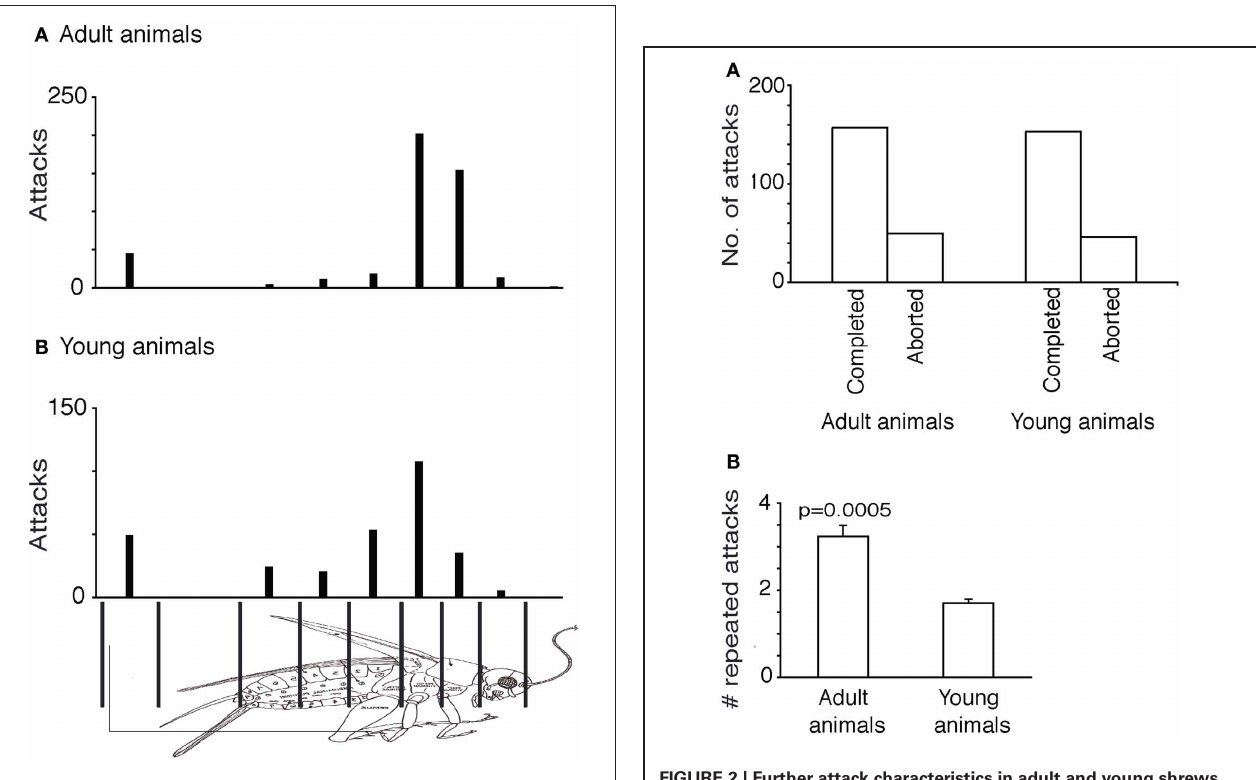
FIGURE 1 | Comparison of attack histograms in adult and young shrews. (A) Histogram of adult shrew attacks over nine body parts. About three quarters of (358 of a total of 456) attacks targeted the thorax. (B) Histogram of young (directly after weaning) shrew attacks over nine body parts. Young shrews also attack preferentially the thorax but the preference is less strong than that in adults. The fraction of attacks placed on the thorax (79% of 456 attacks) in adults was significantly different from the fraction of thorax attacks (48% of 300 attacks) observed in young animals (Fisher’s exact test, two-tailed, p < 0 . 0001).